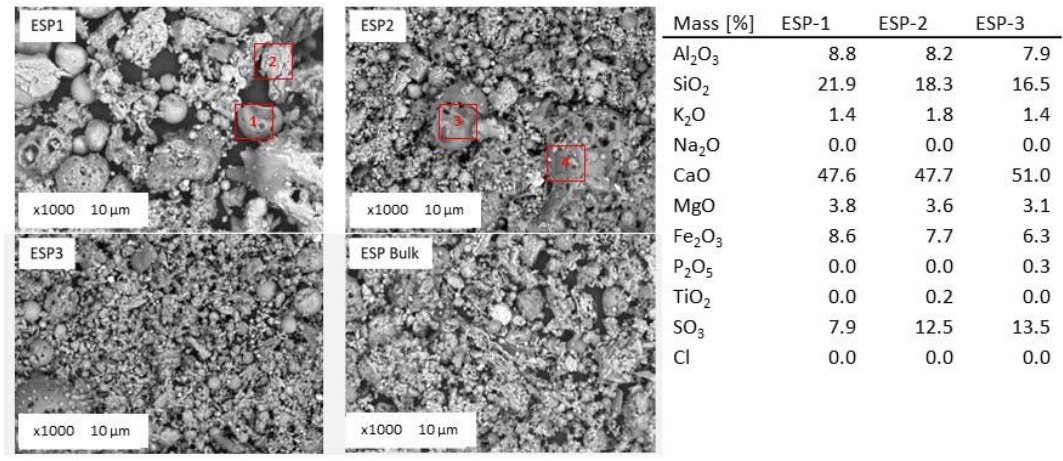
Figure 15. Backscattered electron images of fly ash from 10% thermal share Cynara co-firing.